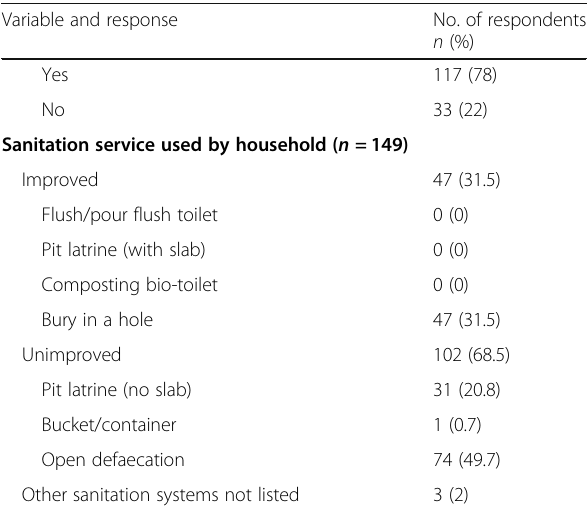
Table 2 Mongolian herding household water, sanitation, and hygiene access and behaviours ( n = 150)